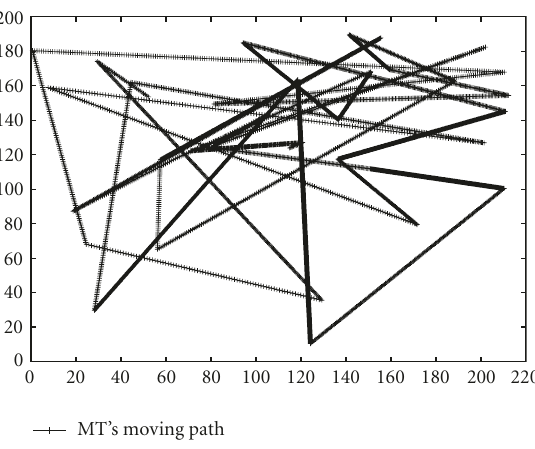
Figure 6: Examples of the random waypoint.